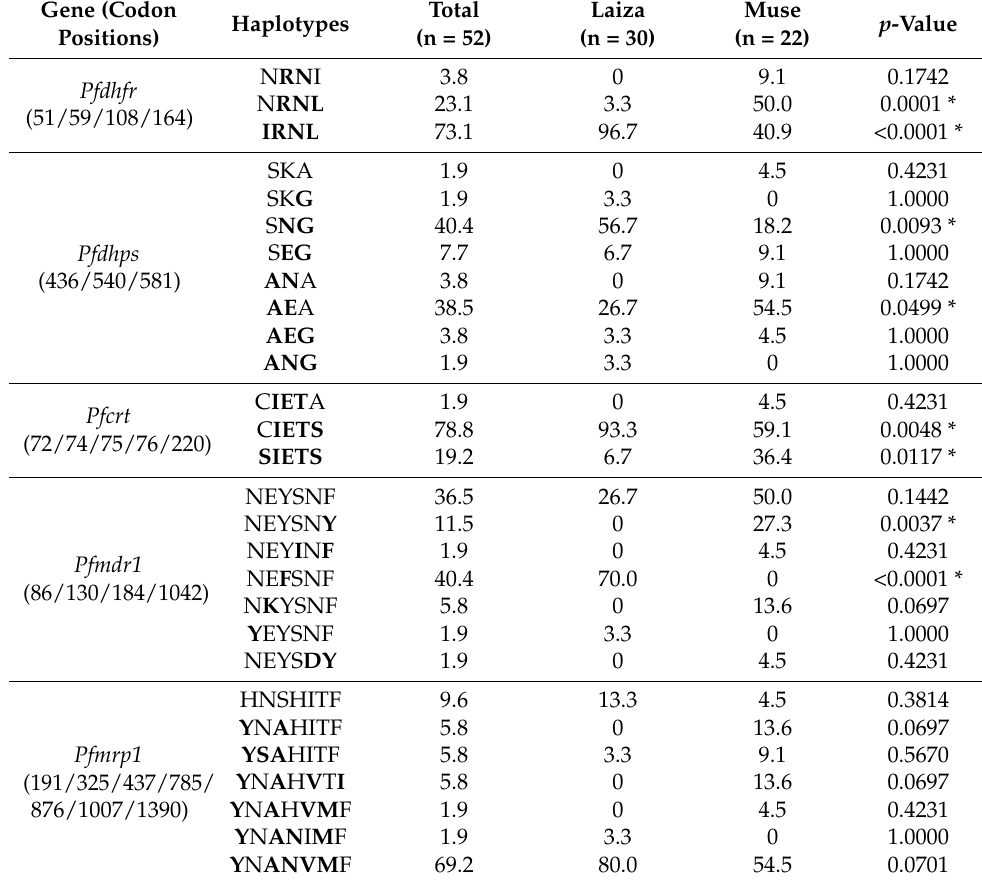
Table 3. The prevalence of haplotypes of resistance